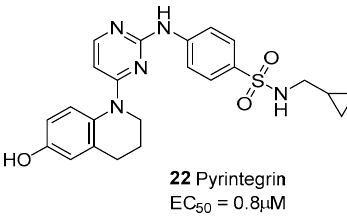
Figure 9. Laminin-binding integrin agonists.